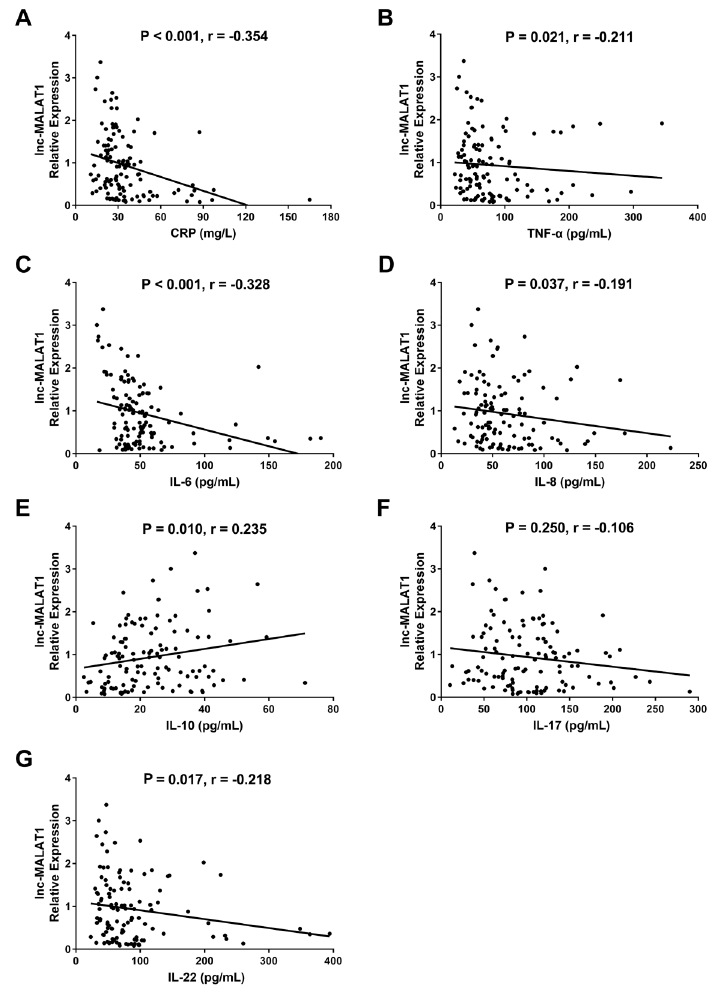
Figure 3. Correlation of lnc-MALAT1 expression with C-reactive protein (CRP) ( A ), tumor necrosis factor a (TNF- a ) ( B ), interleukin (IL)-6 ( C ), IL-8 ( D ), IL-10 ( E ), IL-17 ( F ), and IL-22 ( G ) was determined by the Spearman rank test. lnc-MALAT1: long non-coding RNA metastasis-associated lung adenocarcinoma transcript